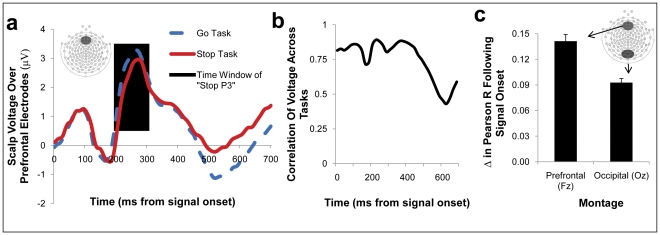
Prefrontal event-related potentials do not strongly distinguish the tasks.A prefrontal positivity peaking around 300 ms, known as the “Stop P3,” has been previously associated with stopping, but this component (darkened region of A) was significantly enhanced in the (Double) Go task. Individual differences in voltage were also highly correlated across tasks, indicating substantial overlap in the underlying cortical processes (B). Moreover, prefrontal correlations between the scalp voltage recorded across tasks were disproportionately increased following the presentation of the signal, relative to the increase in occipital correlations observed at the same time (C). This difference indicates increased cross-task similarity in prefrontal processing specifically at signal onset.